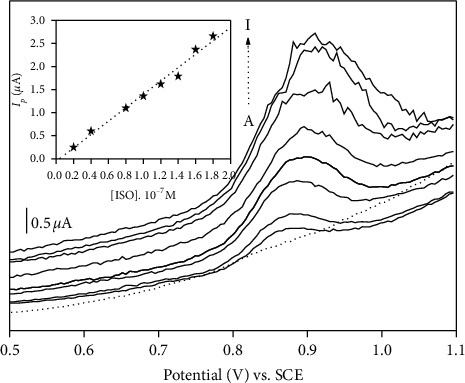
Dependence of the SWV peak current with increased ISO concentration from (a) to (i) 2 × 10−8; 4 × 10−8; 8 × 10−8; 1 × 10−7; 1.2 × 10−7; 1.4 × 10−7; 1.6 × 10−7; 1.8x10−7M. The inset shows the corresponding calibration curve.